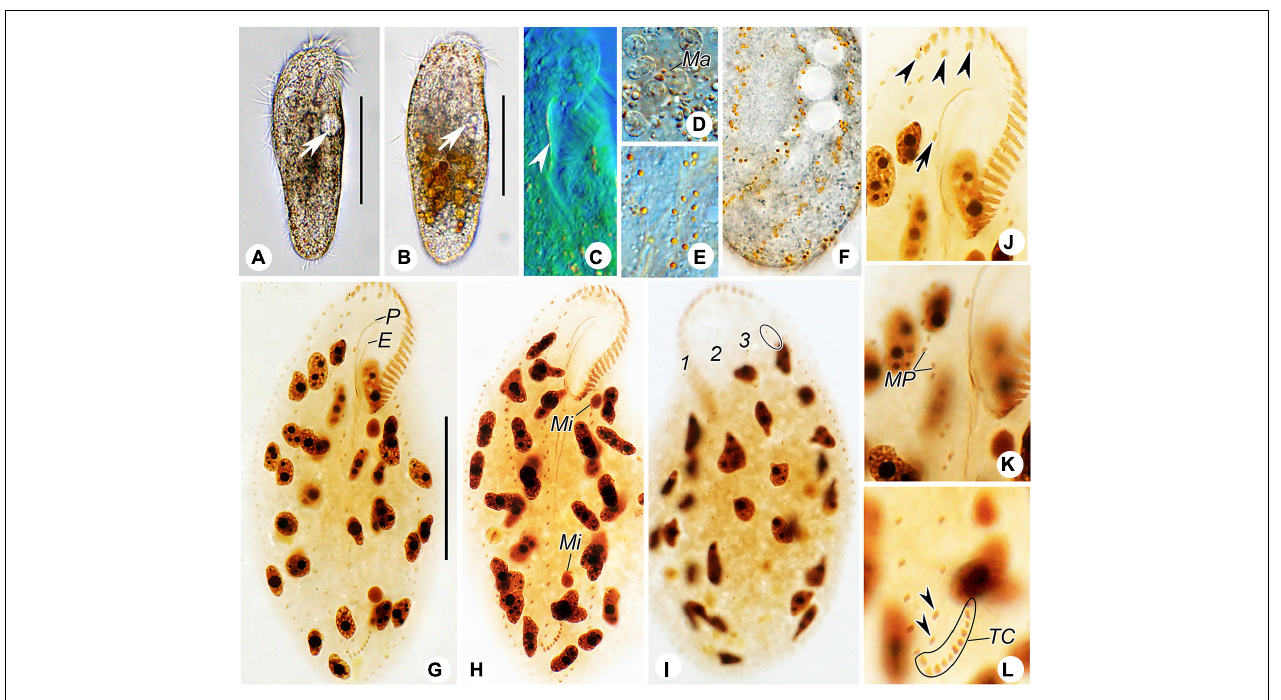
FIGURE 3 | Photomicrographs of Heterobakuella bergeri gen. nov., sp. nov. from life (A–F) and after protargol impregnation (G–L) . (A,B) Ventral views of two representative specimens; arrows indicate the contractile vacuole. (C) Ventral view to show the undulating membranes. (D) Macronuclear nodules. (E,F) Ventral (E) and dorsal (F) views to show the arrangement of cortical granules. (G,H) Ventral overviews of the holotype (G) and a paratype (H) specimen, showing the ciliary pattern. (I) Dorsal view of a paratype specimen, to demonstrate dorsal kineties and the nuclear apparatus. Circle marks two additional dorsal bristles. (J) Ventral view, to show three frontal cirri (arrowheads) and buccal cirrus (arrow). (K) Ventral view, showing the midventral cirral pairs. (L) Ventral view, to show two pretransverse cirri (arrowheads) and transverse cirri. E, endoral membrane; Ma, macronuclear nodules; Mi, micronuclei; MP, midventral cirral pairs; P, paroral membrane; TC, transverse cirri; 1–3, dorsal kineties 1–3. Scale bars = 50 µ